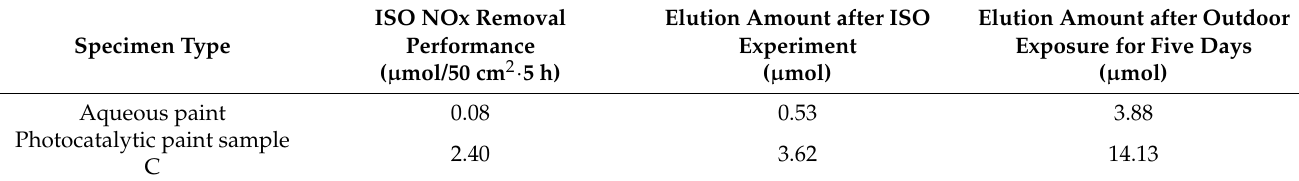
Table 9. Washing water field test results of specimens for which the surface was washed sufficiently.